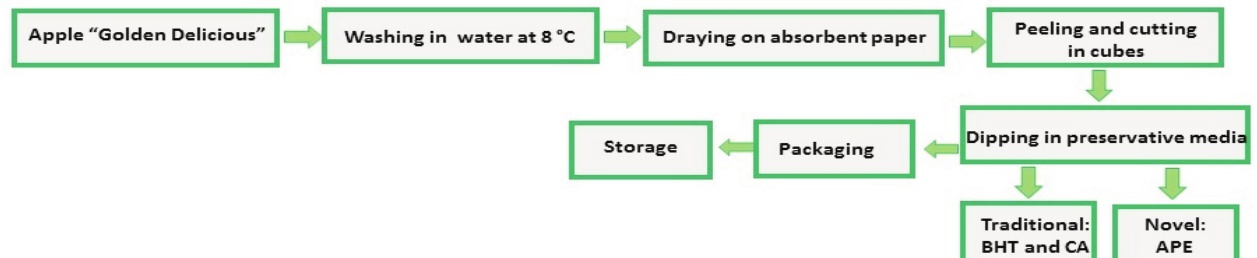
Fig. 1 ­ Experimental procedure to compare different preservative treatments on fresh­cut apple cubes with traditional (1% butylated hydroxytoluene ­ BHT ­ and citric acid ­ CA) and novel extracts from potato and apple (APE) peels.